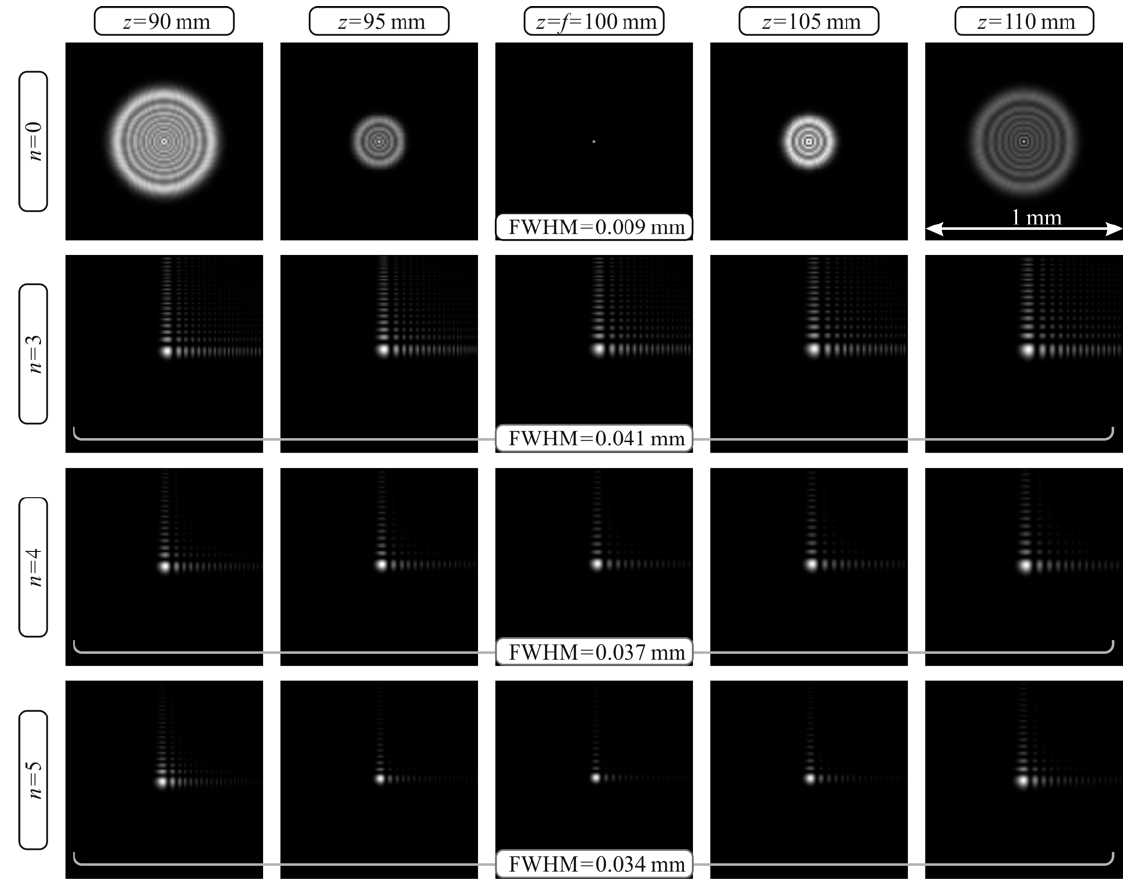
Figure 6. PSF with a CoC size limit of 0.04 mm ( α = 0.0015) at different distances (1 mm × 1 mm pattern size) for a lens without apodization (first row) and with phase apodization n = 3 (second row), n = 4 (third row), and n = 5 (fourth row), for λ = 550 nm.